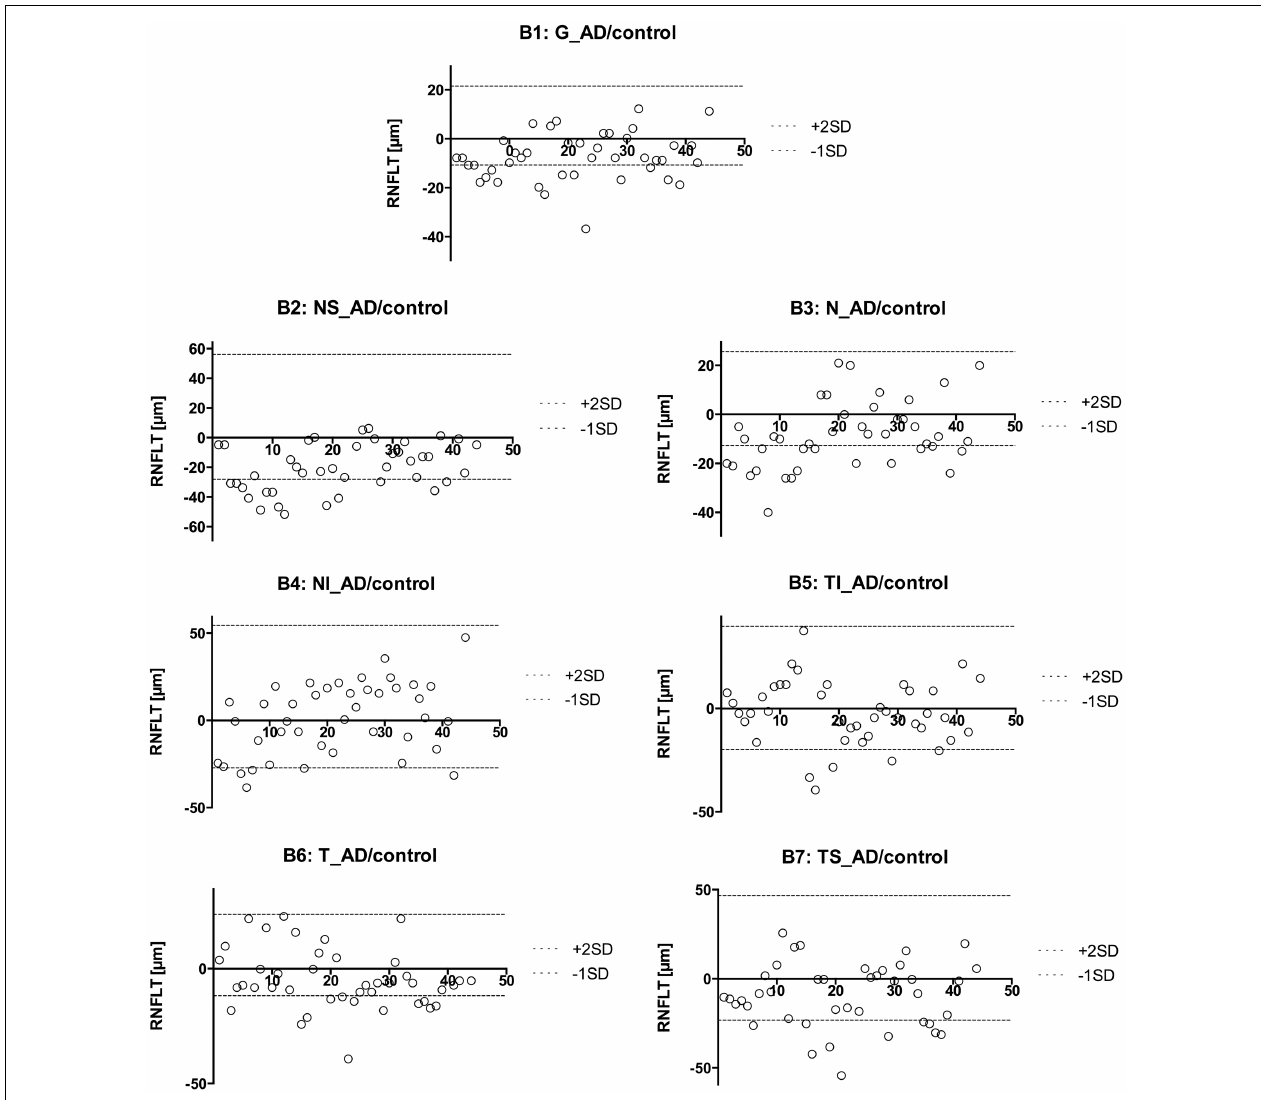
temporal (T, B6), and temporal superior (TS, B7). A circle represents the AD eyes.This way, we were able to identify patients with an RNFL increase or atrophy.We found 67 abnormal sectors and 32 eyes with pathologic RNFLT (out of 42